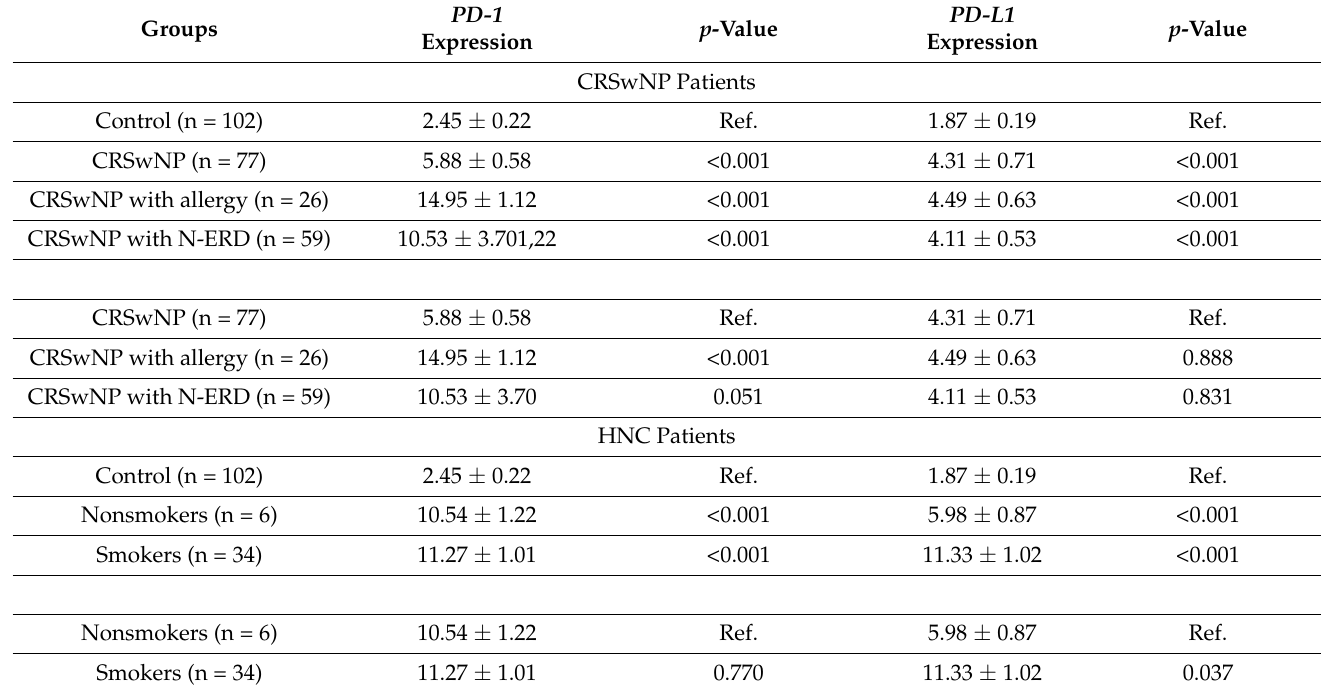
Table 2. mRNA expression level of PD-1 and PD-L1 genes in different subgroups of CRSwNP and HNC